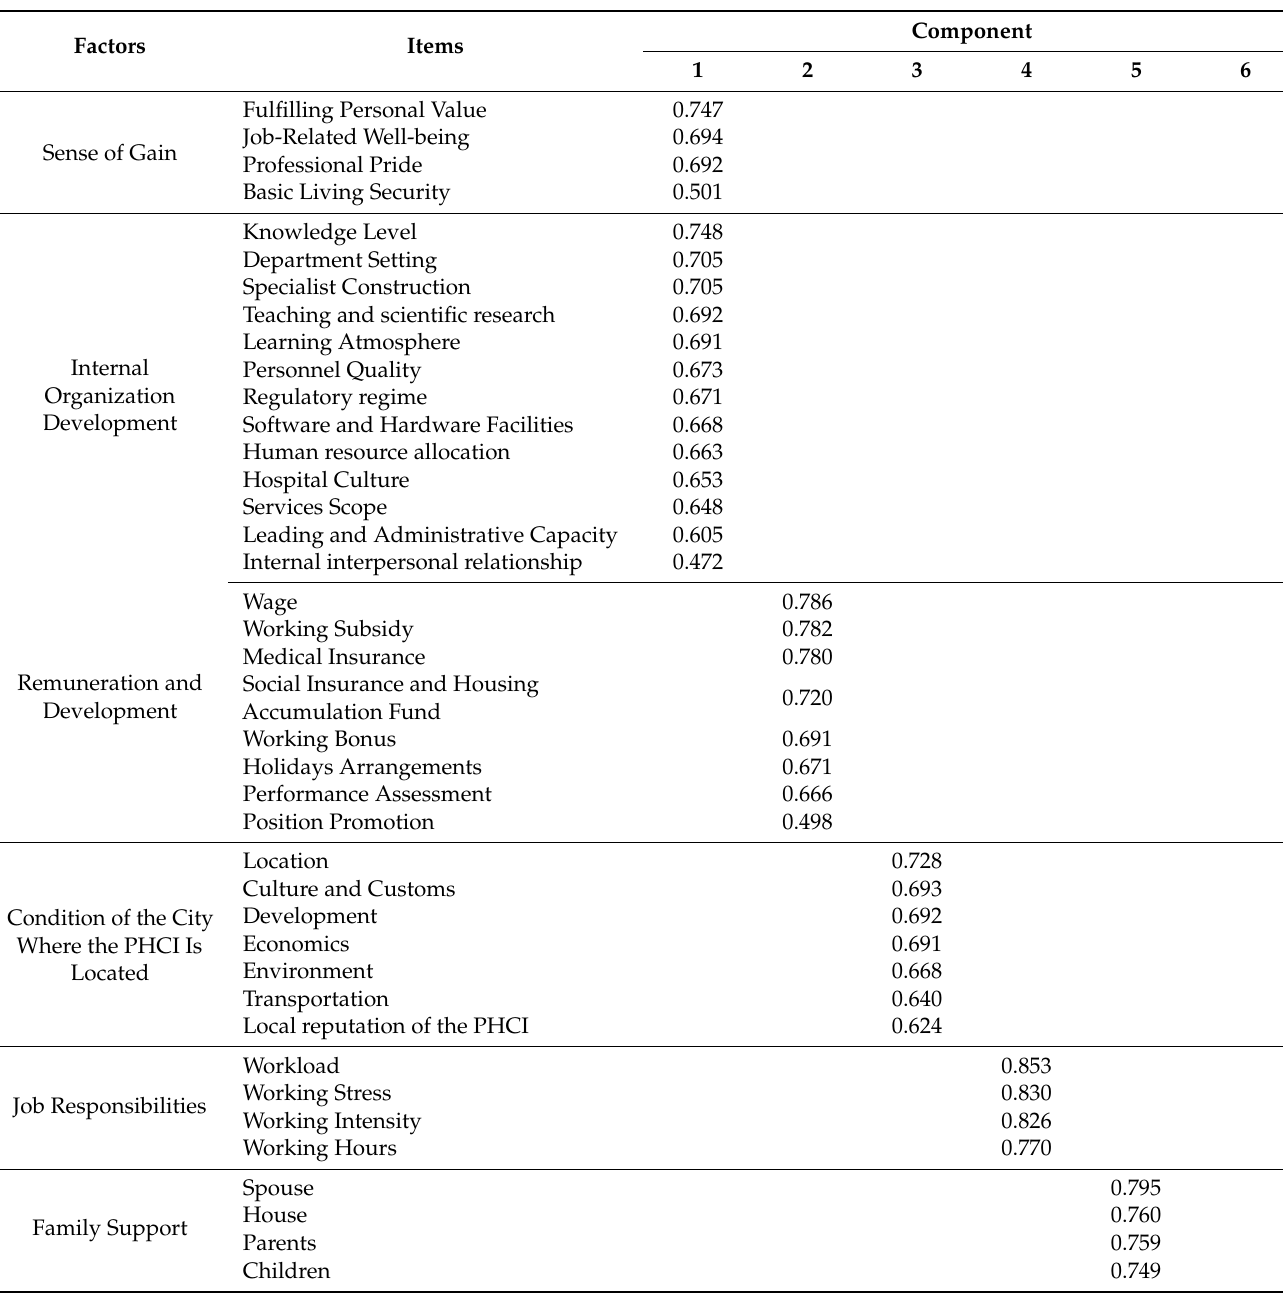
Table 2. The results of the final